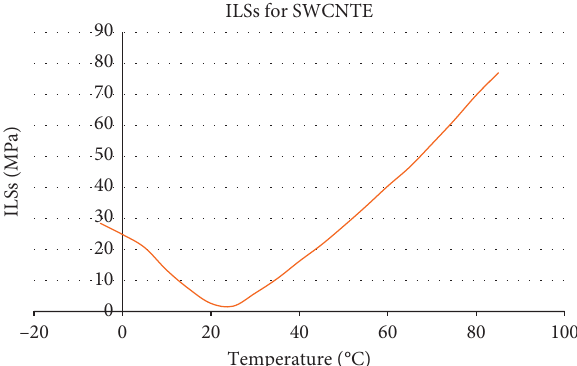
Figure 9: ILSs on interfaces of SWCNT and epoxy at temperature range of − 5 to 85 ° C in